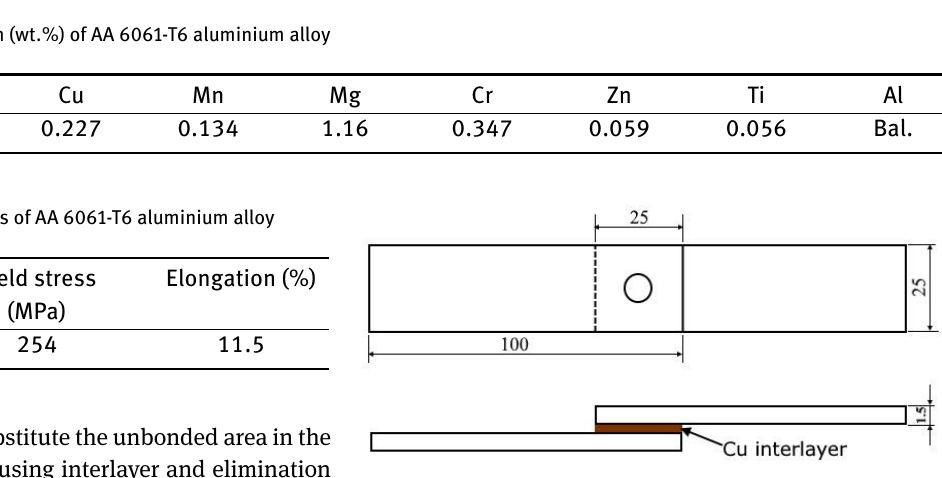
Figure 2: Schematic illustration of the tensile-shear specimen and the position of Cu interlayer (all dimensions in millimetre)